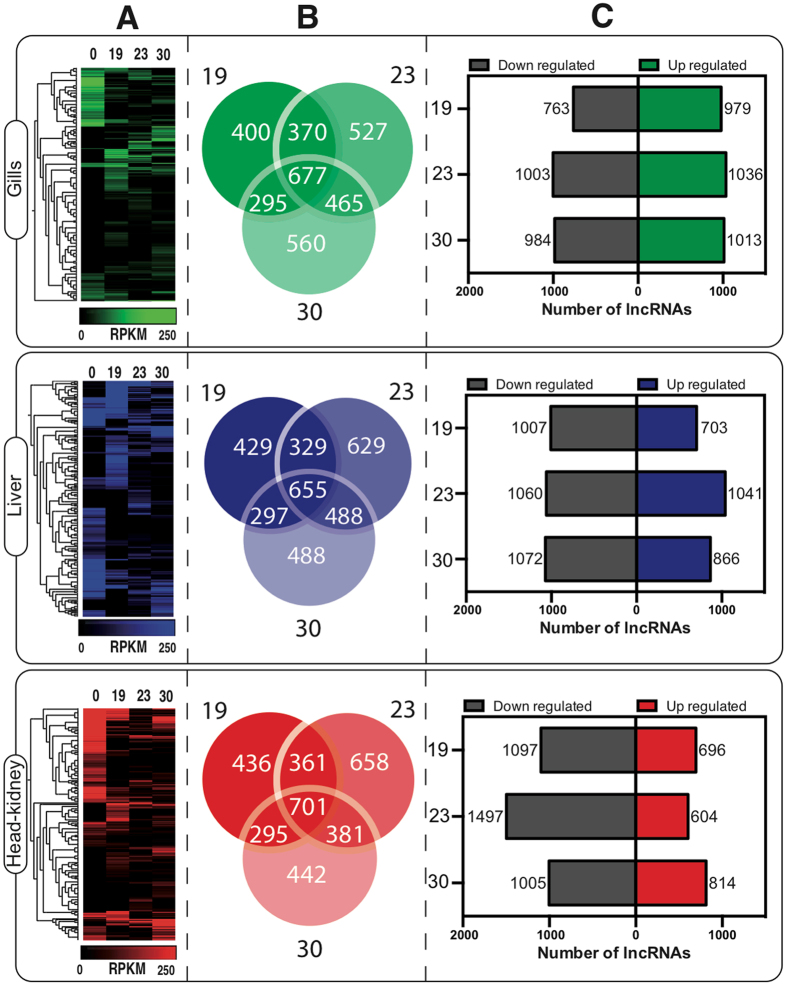
Temporal, specific expression of lncRNAs in the gills.(A) Heat-map and cluster selection of differentially expressed lncRNAs in the gills, liver and headkidney over the course of ISAV infection (green blue and red respectively). Hierarchical clustering with log-transformed RPKM values, showing the most differentially expressed genes (|Fold-change| > 2 and p-value < 0.01) at 19, 23, and 30 DPC. The color intensity represents RPKM values, where colours (green blue and red) indicates a presence and black an absence of regulation. (B) Venn diagram of the differentially expressed lncRNAs at the sampled times. (C) Number of lncRNAs up/downregulated in each tissue infected with ISAV. The bars indicate the fold-change values and RPKM expression values at each sampling point (19, 23, and 30 DPC).